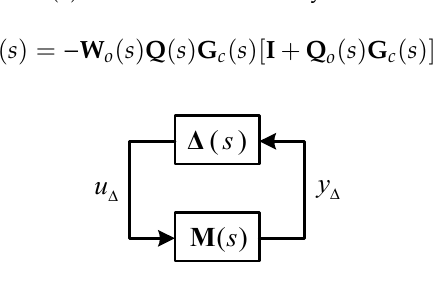
Figure 7. M -Δ structure for robustness analysis.